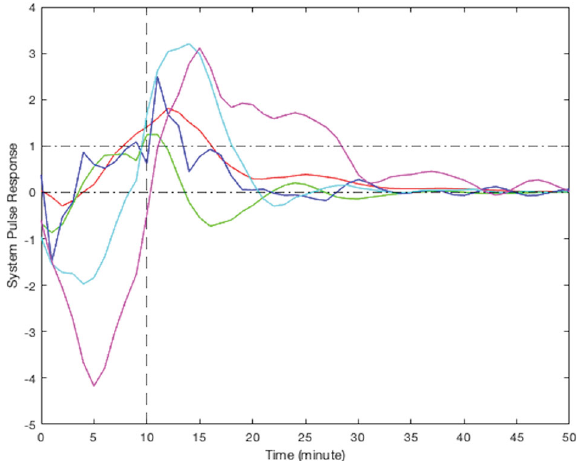
Fig. 9 Pulse response for participants in cluster 5, instant decrease in the odds of smoking followed by a sharp delayed increase. The vertical line at the 10-min mark on the x -axis re fl ects the time when the stress probability returned to